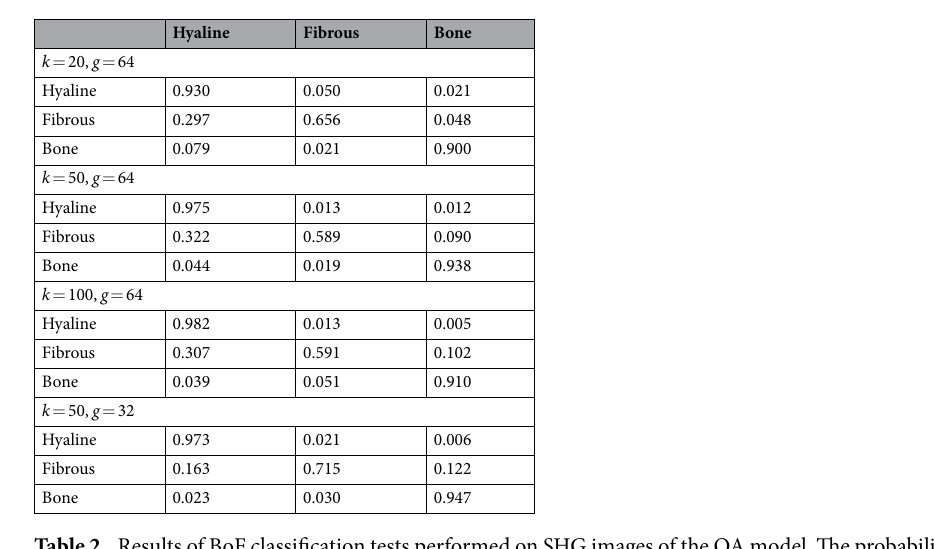
Table 2. Results of BoF classification tests performed on SHG images of the OA model. The probability of the confusion matrix is shown. Texture BoF method for k = 20, 50, or 100 and g = 32, 64 are